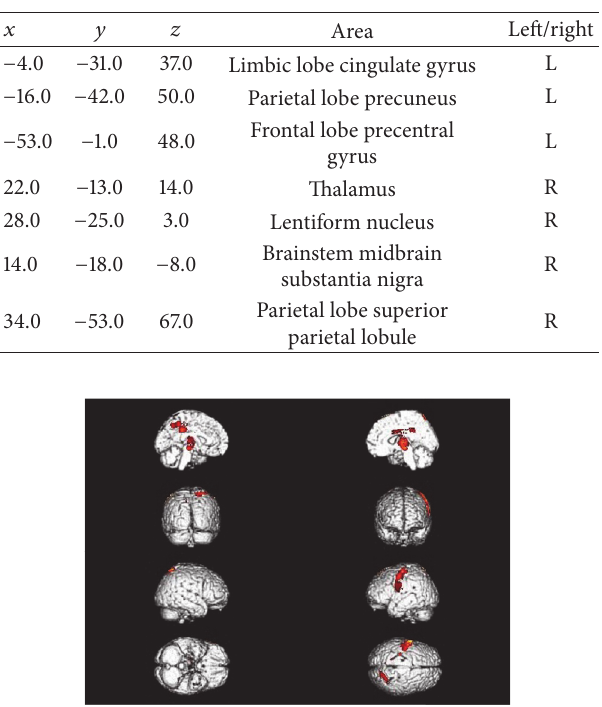
Table 1: Coordinates of Talairach’s Atlas ( 𝑥/𝑦/𝑧 axis) resulting from hypometabolic contrast SPM- 𝑡 analysis of all the affected subjects (DG) versus control group.